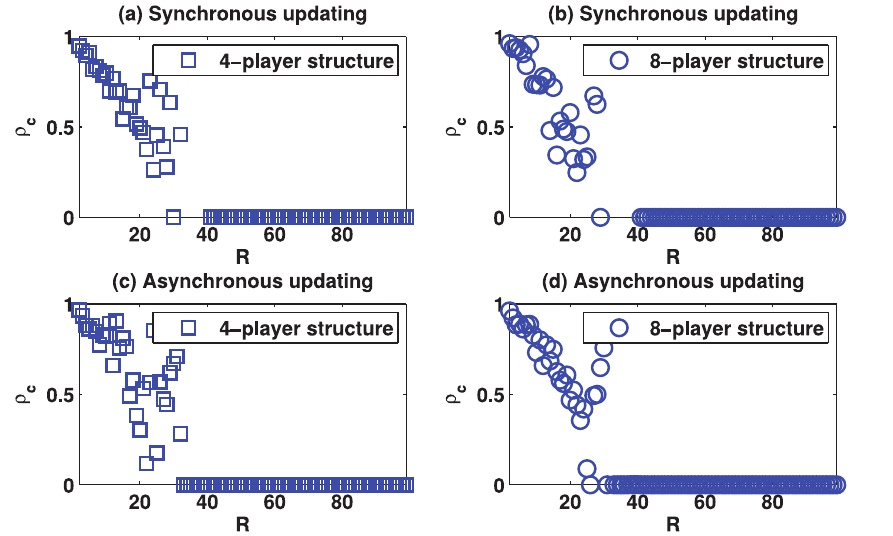
Figure 10. (Color online) Cooperation level r c as a function of the parameter R on different square lattices under the Fermi rule. (a) Results on the square lattice with 4-player neighborhood and synchronous updating; (b) Results on the square lattice with 8-player neighborhood and synchronous updating; (c) Results on the square lattice with 4-player neighborhood and asynchronous updating; (d) Results on the square lattice with 8-player neighborhood and asynchronous updating.